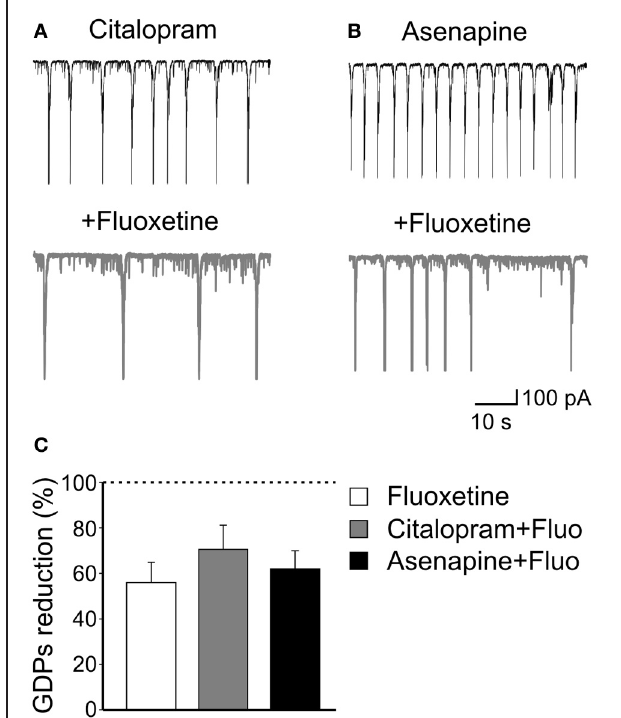
FIGURE 3 | The effects of fluoxetine on GDPs are independent of serotonin uptake or monoamine action. (A) Citalopram, a selective serotonin reuptake inhibitor, at the concentration of 1 μ M enhanced the frequency of GDPs. Addition of fluoxetine (20 μ M) significantly reduced the frequency of GDPs. (B) Asenapine, a monoamine receptors blocker, also increased GDPs frequency that was reduced by subsequent addition of fluoxetine. (C) Summary data for the results shown in (A) and (B) . Fluoxetine-induced reduction of GDPs frequency was similar when the antidepressant was administered alone or together with citalopram or asenapine ( p = 0 . 17).